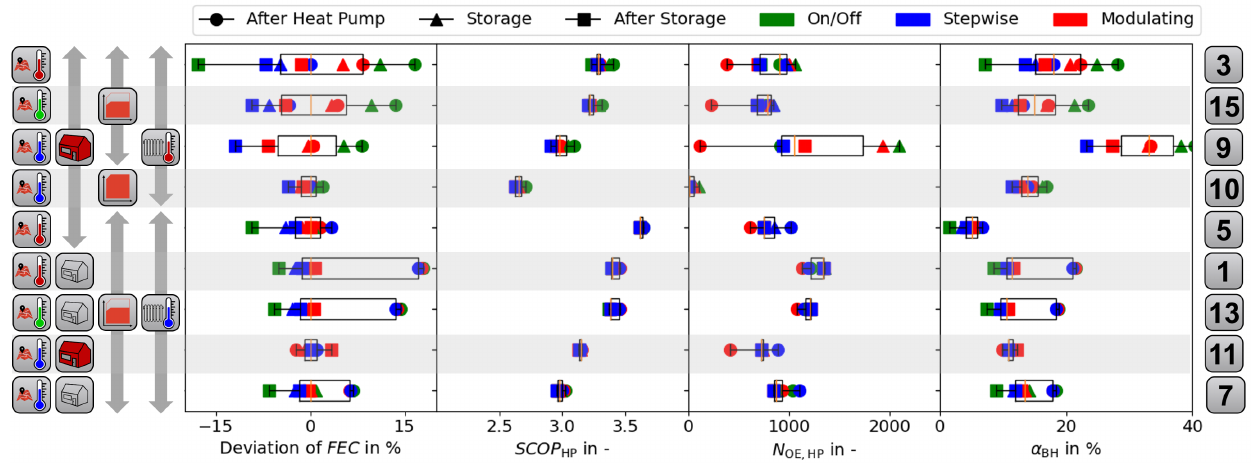
Figure 5. Boxplots of the FEC, the heat pump efficiency, SCOP HP , the BH usage α BH , and the number of times the operational envelope is violated for a selected set of scenarios. See Figure A1 for all